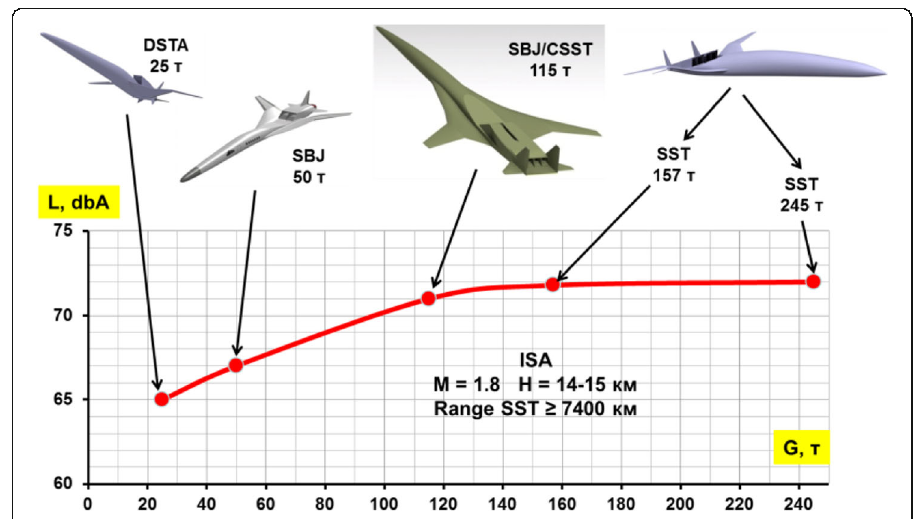
Fig. 8 The dependency of sonic boom loudness at the beginning of cruise supersonic flight at M = 1 . 8 on flight weight of prospective